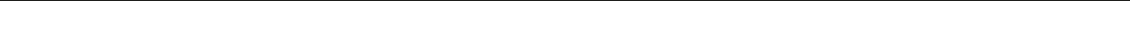
Fig. 3 Discovery and characterization of enhancer activity in IBD a . Conservation analysis of enhancer regions. X -axis shows the distance from the center of regions. Y -axis shows average PhyloP100 vertebrate conservation score 65 for strict and permissive enhancer sets, non-transcribed DHSs from gut 27 and random non-genic regions. P -values indicate Mann – Whitney U tests between conservation scores in the ±200 bp region (dashed lines). Number of regions in each set are shown (overlapping regions were discarded). b Transcription factor binding enrichment within CAGE-de fi ned enhancer regions. Heat map rows correspond to the 10,670 enhancer predictions, sorted by distance between bidirectional CAGE peaks. X -axis corresponds to the ±2000 bp region centered on enhancer midpoints. CAGE peak summits are shown as black lines. Color intensity corresponds to number of ENCODE transcription factor ChIP-seq peaks (all ENCODE cells) overlapping a given region. c H3K27ac and H3K4me1 ChIP-seq enrichment within enhancer regions identi fi ed by CAGE in gut biopsies. Heat maps are constructed as in b , but show ChIP-seq signal from H3K27ac and H3K4me1 from rectal/colonic mucosa, T helper and CD14 + cells 27 . Colors are assigned based on observed min and max ChIP-seq intensity values within each heatmap. d Principal component analysis based on CAGE expression within enhancer regions. Plot is organized as Fig. 2a. e Number of differentially expressed enhancers. Bar plot shows the number of differentially expressed enhancers per group, organized as Fig. 2b. f Predicted transcription factor site enrichment in enhancer and TSS regions. Each row shows data related to one transcription factor. Left panel shows site enrichment P value in respective groups of differentially expressed enhancers or promoters for the sites corresponding to the relevant motif, as indicated by color scale. Middle panel shows the CAGE expression as log 2 TPM for the transcription factor across groups as boxplots. Right panel shows motif sequence logo. g Linkage between enhancer and TSS through co-expression. Y -axis shows the fraction of CAGE TSSs that can be linked to enhancers within 500 kb through co-expression correlation, split by how many enhancers each TSS is linked to. X -axis shows sets of TSSs split by their differential expression as in Fig.